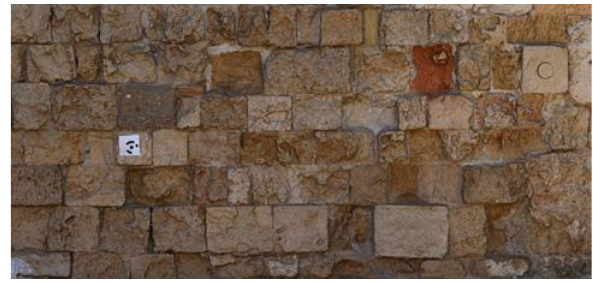
Figure 8: Detailed Textured 3D Model.